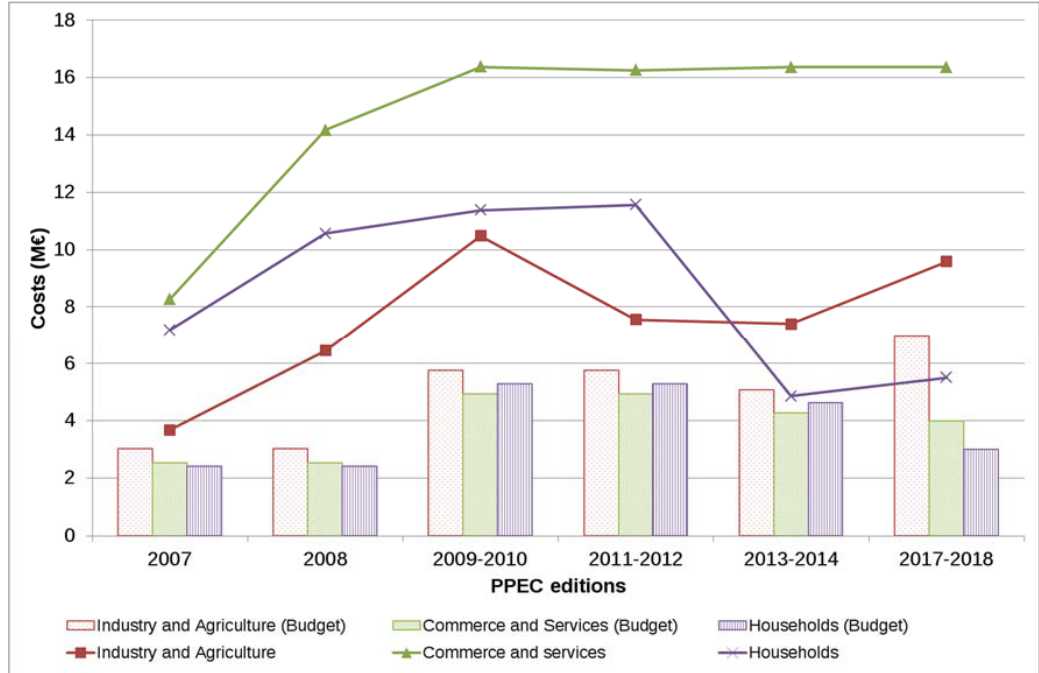
Figure 4. PPEC costs of the eligible tangible measures and corresponding available budget, for each PPEC edition [19–25].